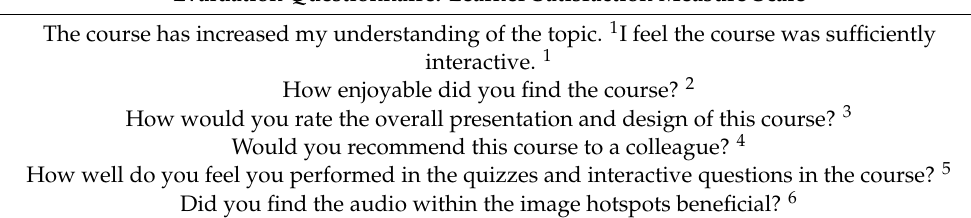
Table A1. Evaluation Questions, Format and